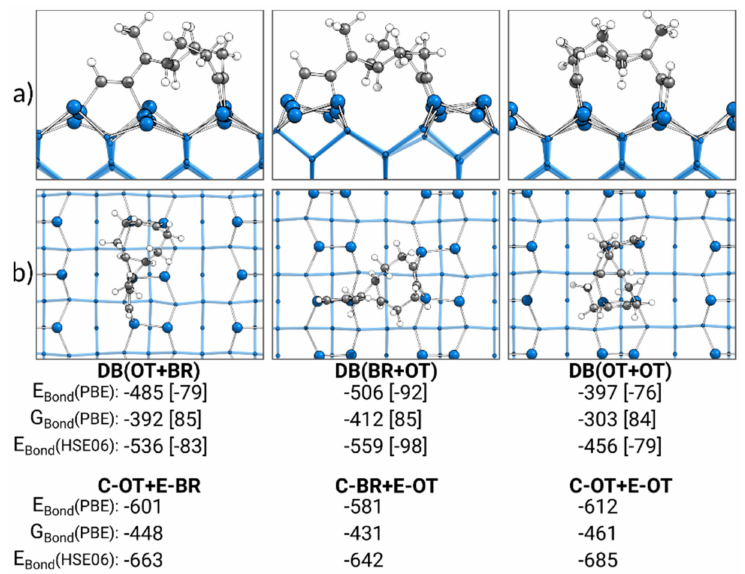
Figure 8. Doubly bonded structures of ECCO on Si(001), with side ( a ) and top ( b ) views of the structures bonded by the cyclooctyne (C) or ethinyl (E) group in the on-top (OT) or bridge (BR) position. Electronic bonding energies (E Bond ) are shown with their dispersion contributions in brackets. Gibbs energies (G Bond ) are shown with their entropy contribution “ − T · ∆ S” at 300 K and 1 atm in brackets. In addition, the sum of the two corresponding singly bonded structures is